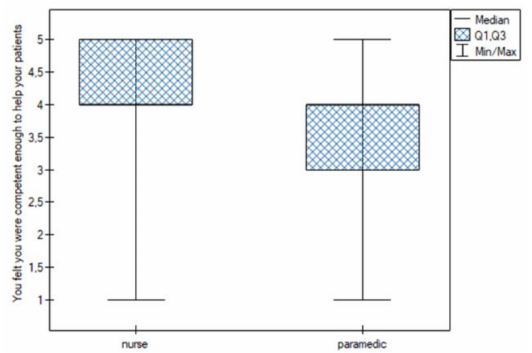
Figure 4. Sufficient